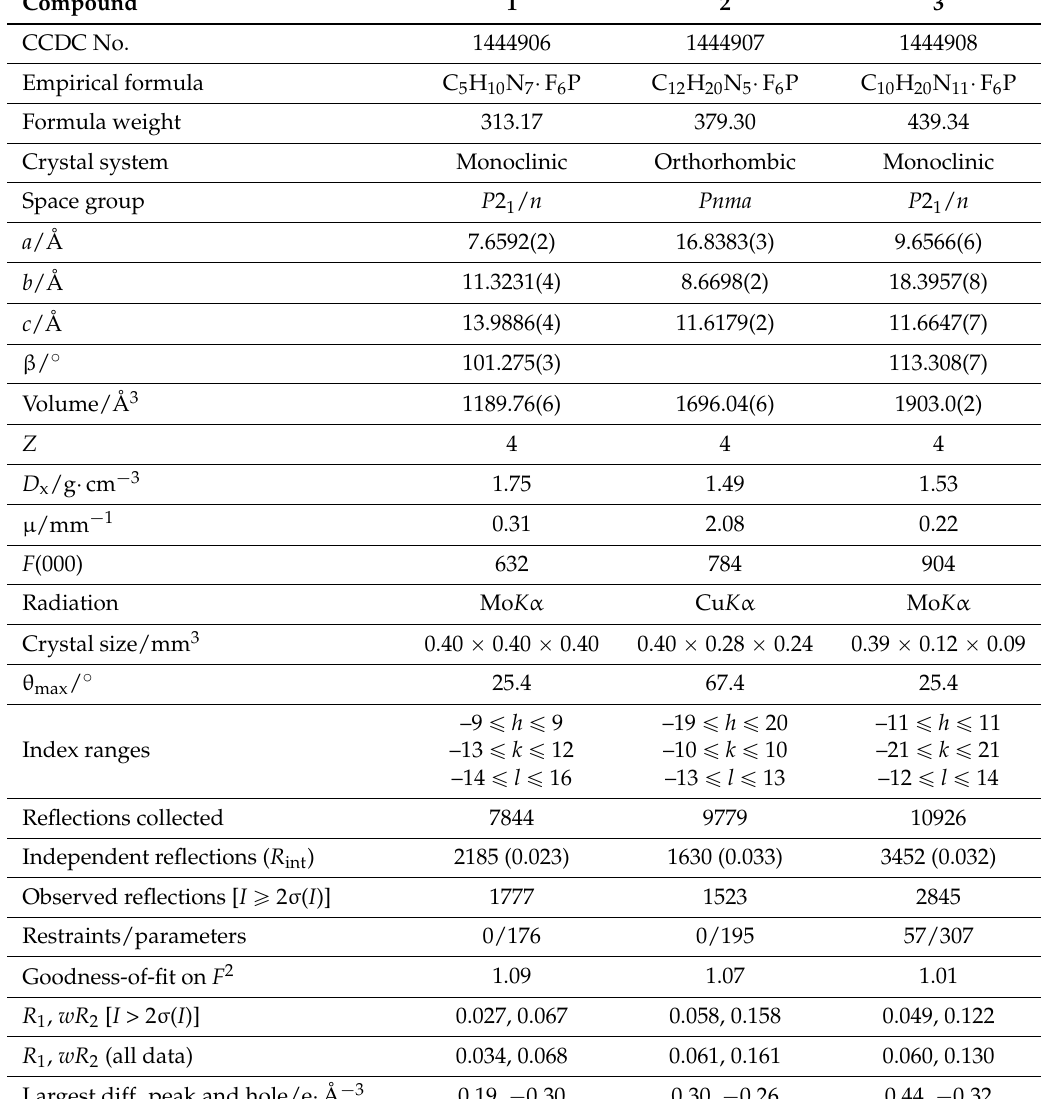
Table 1. Crystal data and structure refinement details for compounds 1 – 3 .